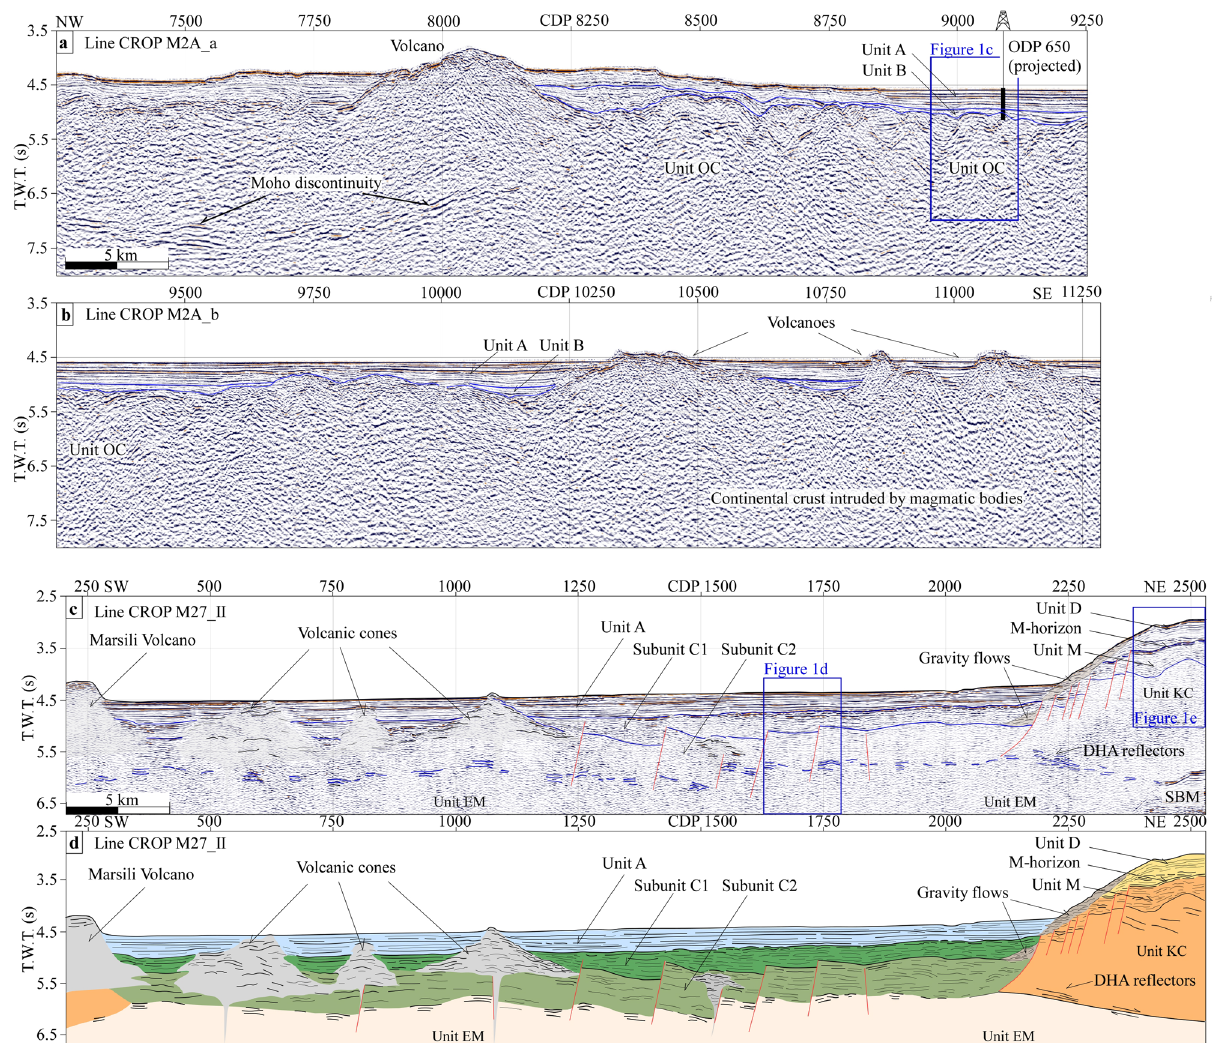
Figure 2. ( a and b ) Seismic line CROP M2A and its interpretation. ( c ) Seismic line Crop M27_II and ( d ) its line drawing interpretation. SBM: Sea-bottom multiple; T.W.T.: two ‐ way travel. See Fig. 1b for the location of the seismic